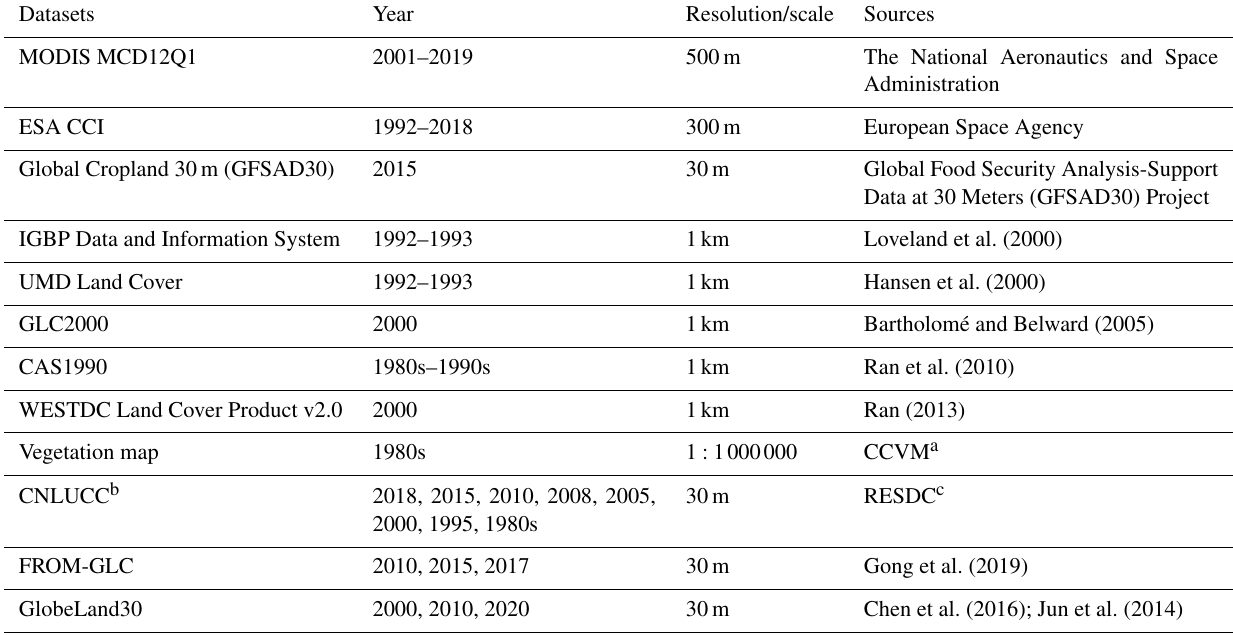
Table 2. Gridded data collected for cropland reconstruction.